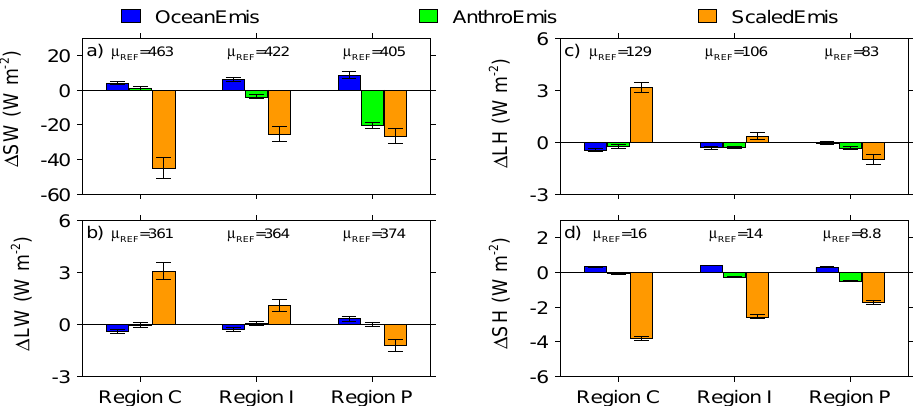
Fig. 7. Same as in Fig. 2, but for responses in mean surface energy fluxes including downward shortwave (SW, panel a ), downward longwave (LW, panel b ), latent heat (LH, panel c ), and sensible heat (SH; panel d ) to regional oceanic (OceanEmis, blue), anthropogenic (AnthroEmis, green), and enhanced anthropogenic (ScaledEmis, orange) emissions. Note the different vertical axis scales.